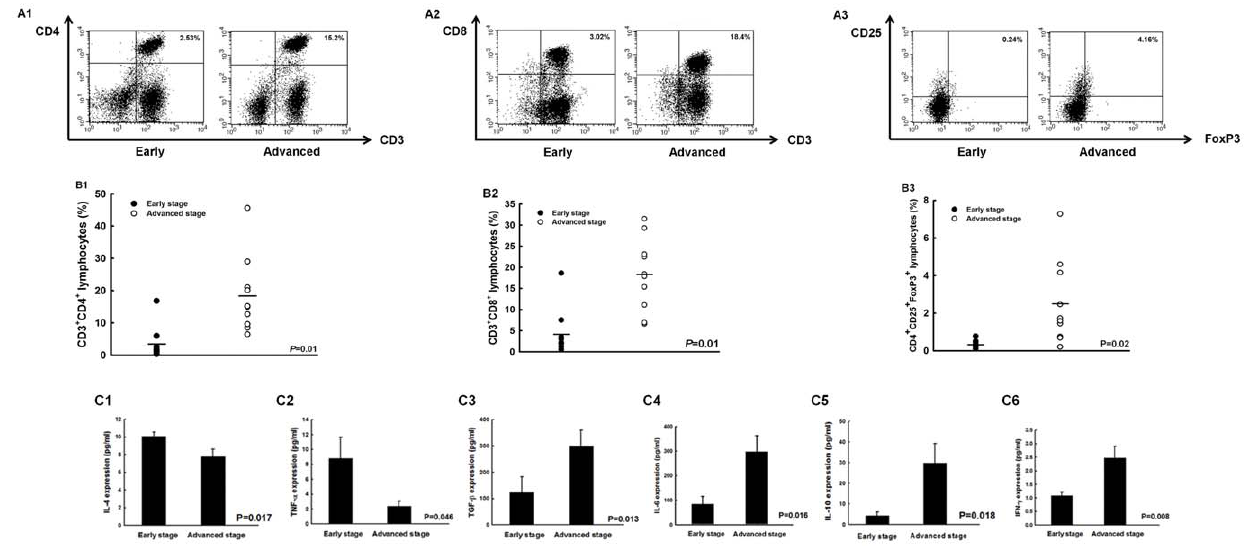
Figure 1. Different expressions of immune components in ascites of early- and advanced-stage ovarian cancer patients. ( A ) Representative figures of flow cytometric analyses of CD4 + helper T cells, CD8 + cytotoxic T lymphocytes, and CD4 + CD25 + regulatory T lymphocytes (Treg cells) in TAL. A1, CD4 + helper T cells; A2, CD8 + cytotoxic T lymphocytes; A3, CD4 + CD25 + Treg cells. ( B ) Percentages of CD4 + helper T lymphocytes, CD8 + cytotoxic T lymphocytes, and CD4 + CD25 + regulatory T lymphocytes (Treg cells) in TAL. B1, CD4 + helper T cells; B2, CD8 + cytotoxic T lymphocytes; B3, CD4 + CD25 + Treg cells. Note : The percentages of CD4 + T cells were significantly higher in patients with advanced stage ovarian cancer. ( C ) Concentrations of various cytokines in ascites of ovarian cancer patients. C1, IL-4; C2, TNF- a ; C3, TGF- b ; C4, IL-6; C5, IL-10; C6, IFN- c . Note : The IL-4 and TNF- a concentrations decreased while the TGF- b , IL-6, IL-10, and IFN- c concentrations increased from early to advanced stage.